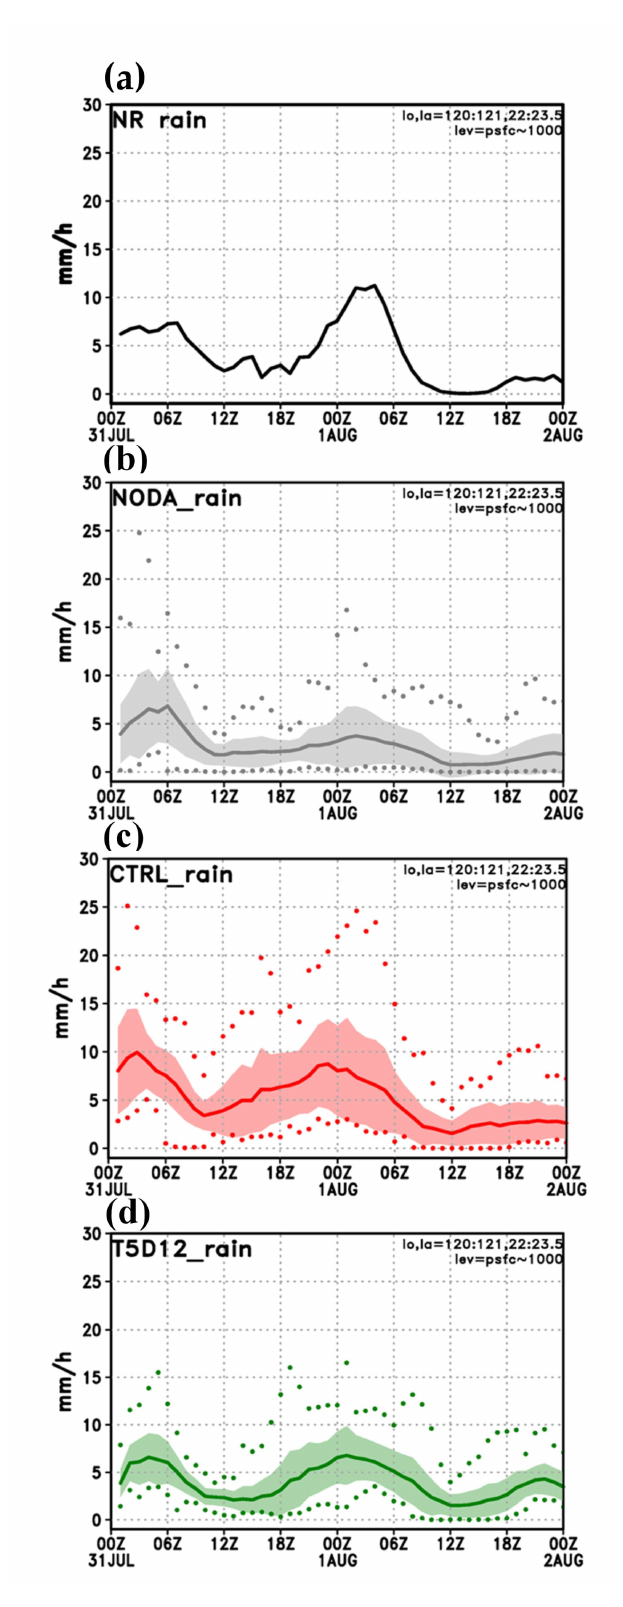
Figure 5. Time evolution of the box-averaged rain intensity (mm h − 1 ) over southwestern Taiwan (gray dashed box in Figure 4a) for ( a ) NR, ( b ) NODA, ( c ) CTRL, and ( d ) T5D12. In ( b – d ), the solid line is the mean, the shaded area denotes the range of one standard deviation, and dots represent the maxima and minima of the 32 ensemble